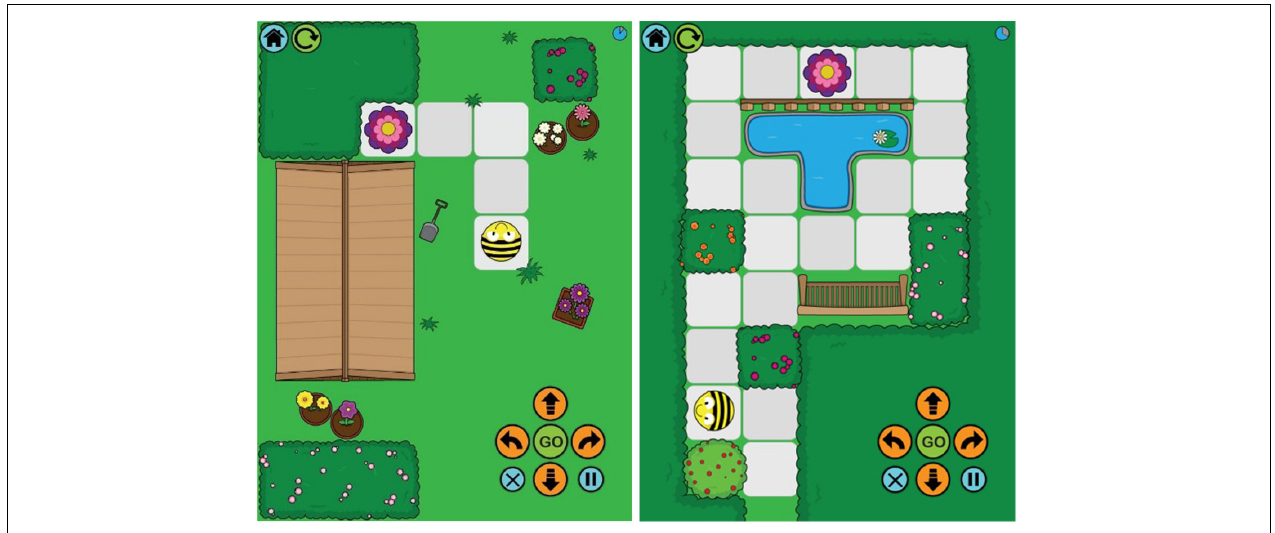
FIGURE 2 | Bee-Bot app showing Routes 3 and 9. Images published with permission from TTS group (https://www.tts-group.co.uk/).